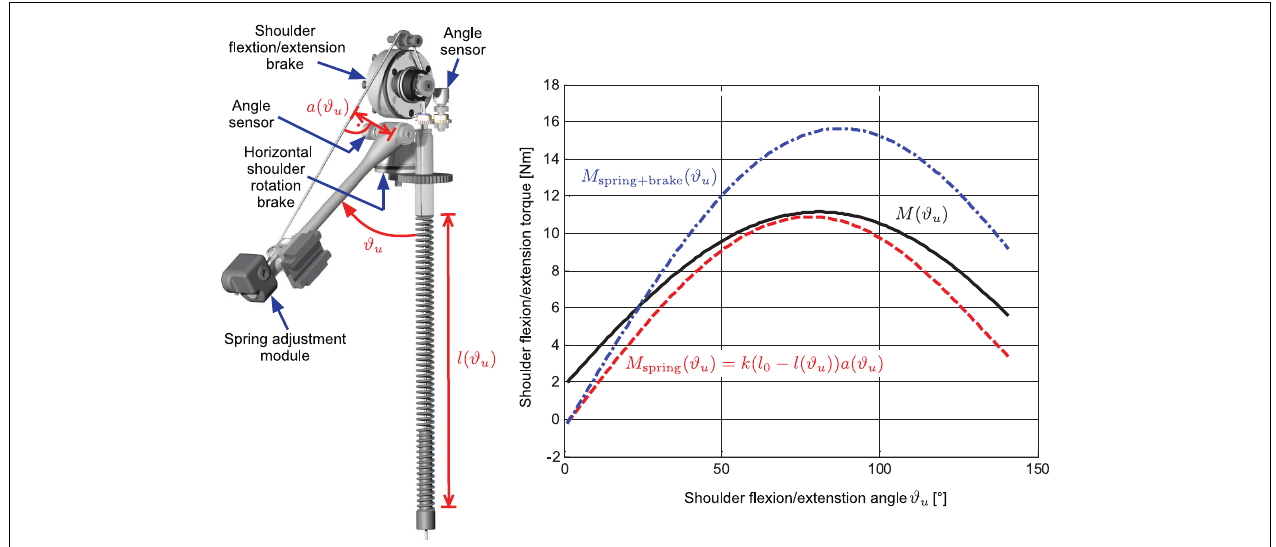
FIGURE 3 | Isometric view of the shoulder joint mechanism showing the angle sensors and brakes for the two degrees of freedom. The right graph shows the occurring torque due to gravity (black solid line) together with the compensation torque (dashed red line) at the shoulder joint as a function of